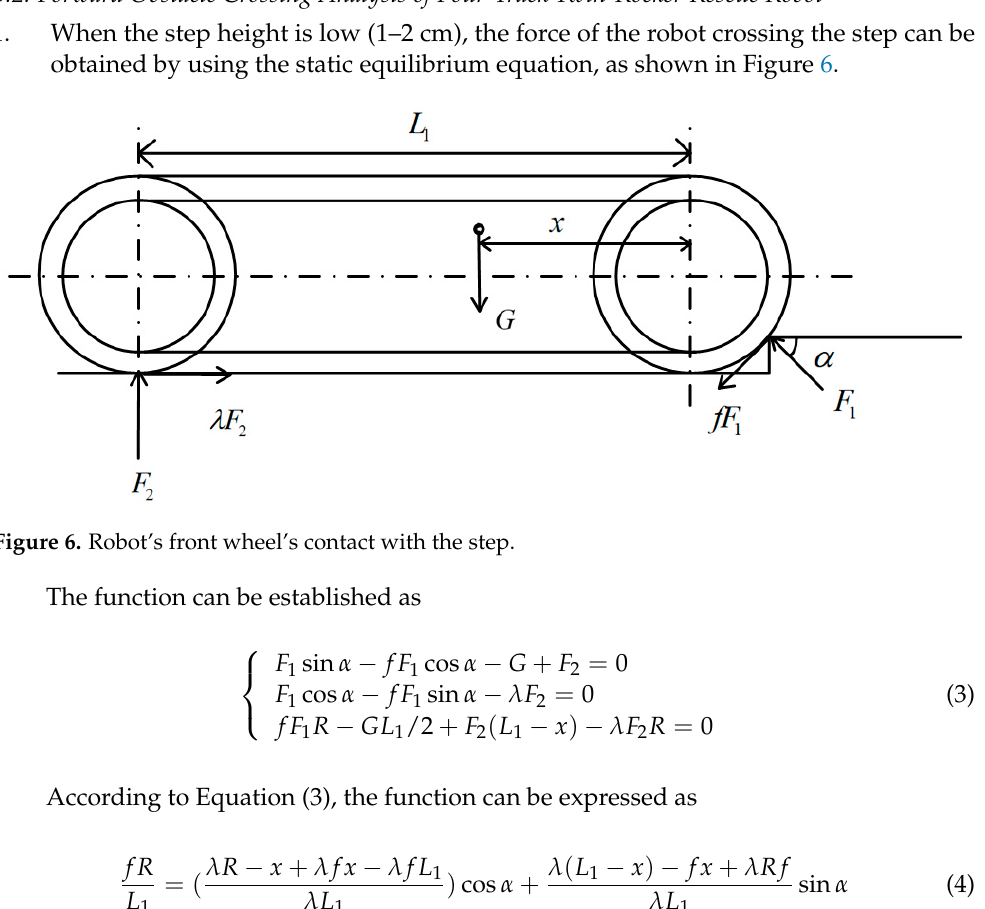
According to Figure 5, the geometric relationship